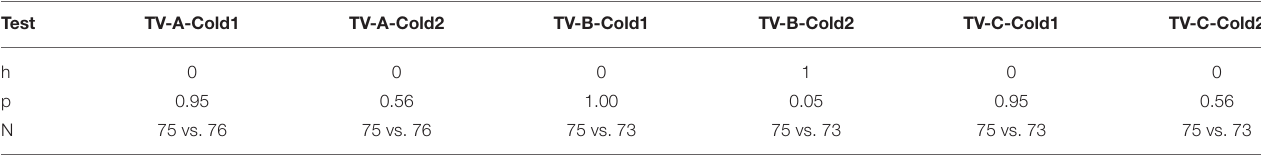
TABLE 4 | Using eVAS, there is no difference in pain response for analgesic A and we see only a marginal difference for analgesic B.